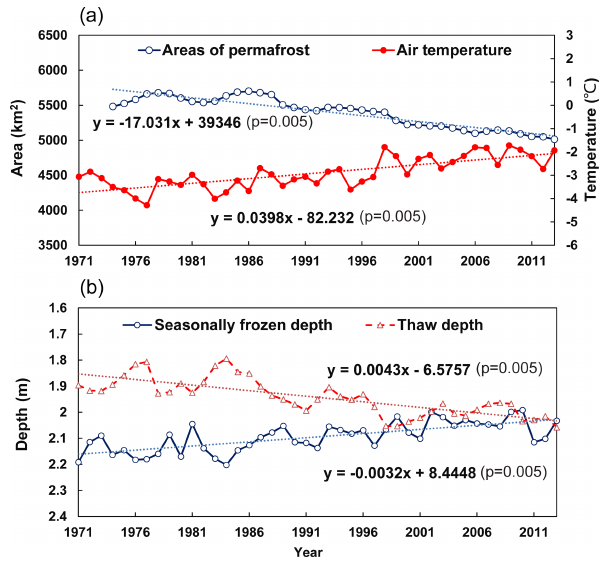
Figure 8. Change of the frozen soils in the upper Heihe basin: (a) ar- eas of permafrost and basin-average annual air temperature; (b) the basin-average annual maximum depths of seasonally frozen ground, and thaw above permafrost. Results from linear regressions are in-